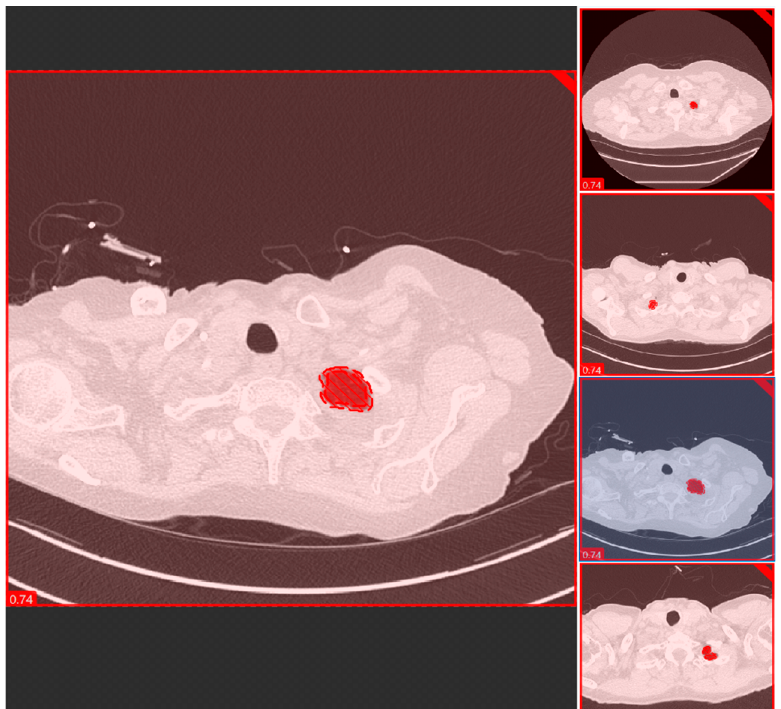
Figure 3. A snapshot of the Red Tool of the DL software used for segmenting and classification of the anatomic locations at the lung apex.